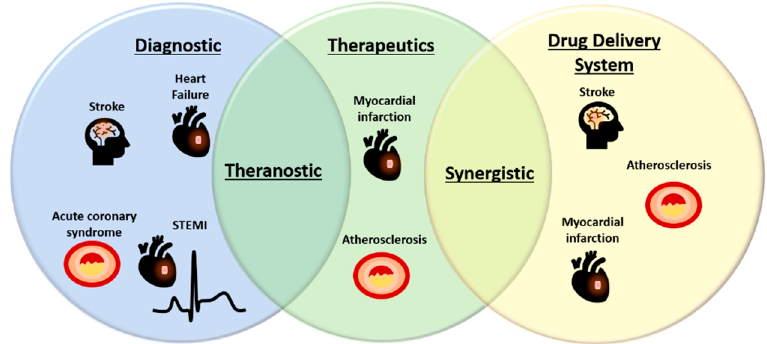
Figure 2. Potential applications of EVs in diagnostic, therapeutic, and drug delivery in CVD. Increasing novel biomarkers identified in EVs have made them as attractive alternative sources of biomarkers for a variety of CVD. On the other hand, EVs also bear intrinsic therapeutic activities and great potential to deliver drugs or therapeutic compounds and therefore, may o ff er synergistic treatment e ff ects. Endogenous EV biomarkers and / or loaded diagnostic agents may be housed together with therapeutic compounds to create theranostic EVs for CVD treatment. STEMI, ST-elevation myocardial infarction.